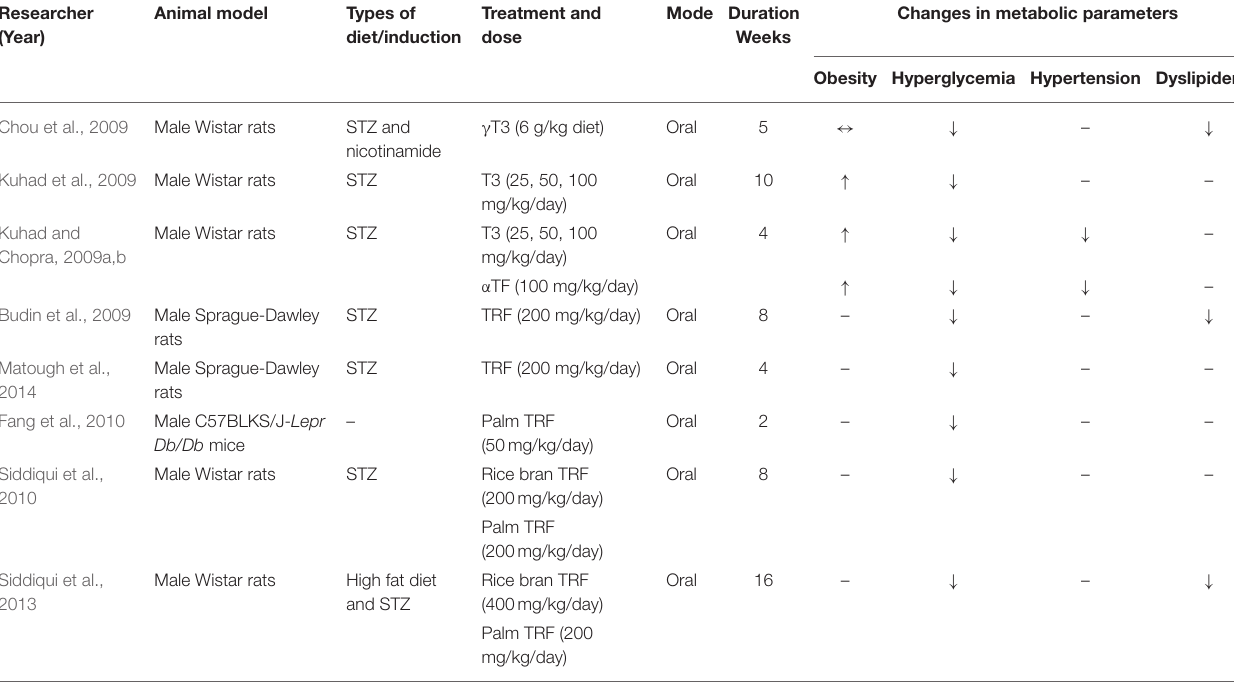
TABLE 2 | The effects of vitamin E on metabolic parameters in diabetic animal models. Researcher